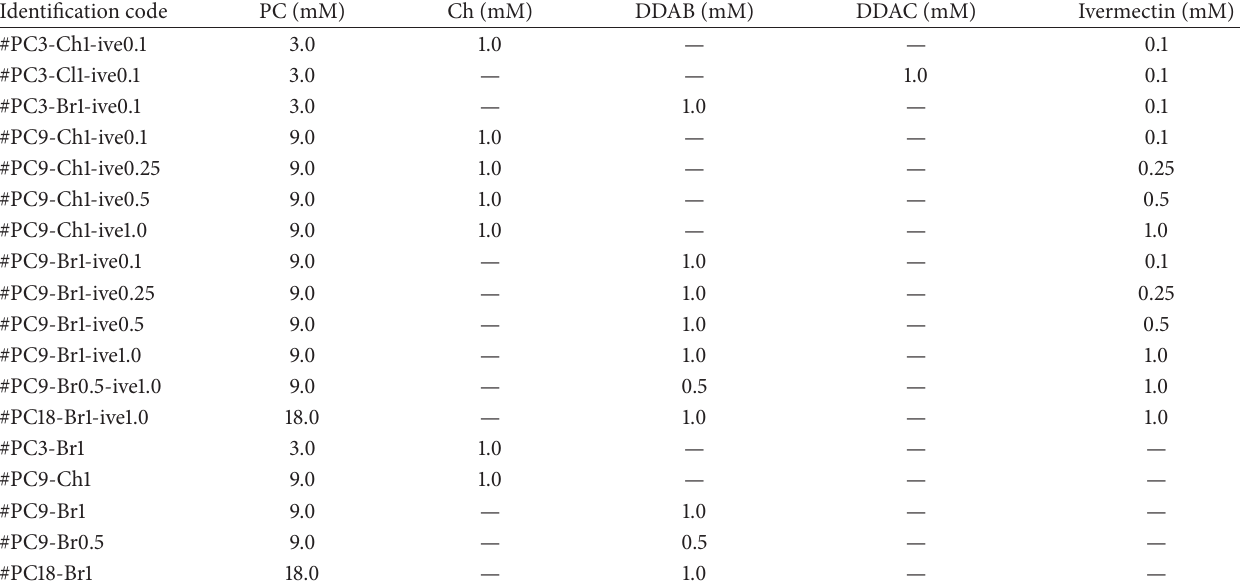
Table 1: Liposomes identification code and composition.